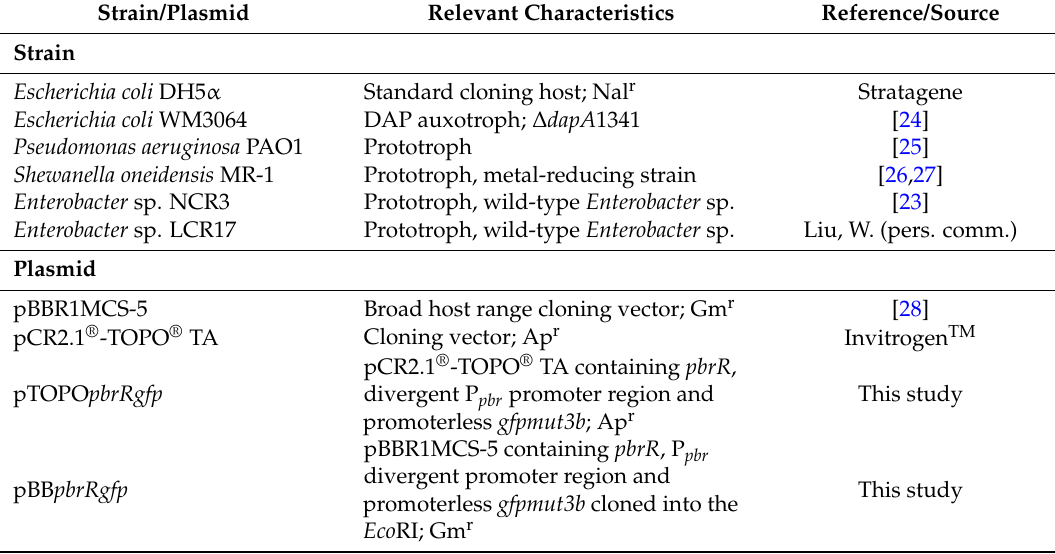
Table 1. List of strains and plasmids used in this